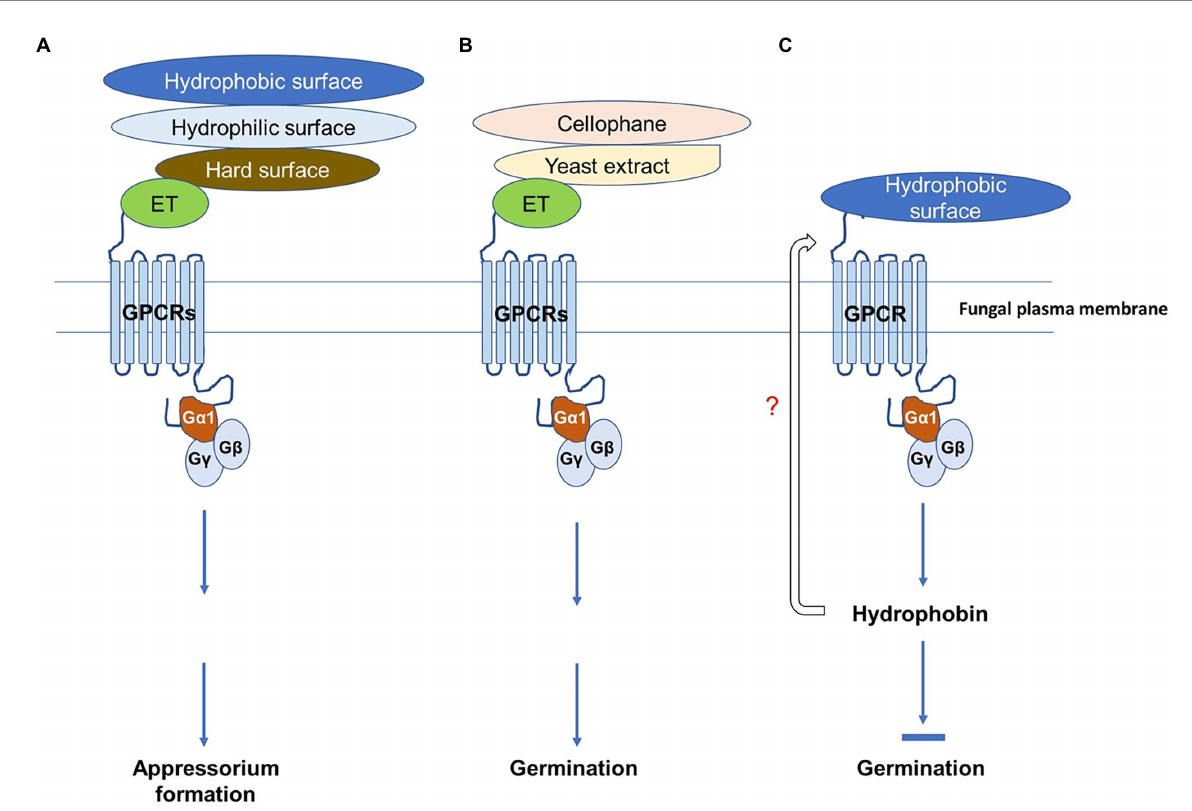
FIGURE 9 Schematic diagram of spore germination and appressorium formation regulated by different surface cues mediated by CaG α 1 (G α 1) signaling in Colletotrichum asianum TYC-2. (A) Surface cue sensing of C. asianum to hydrophobic, hydrophilic and hard surface and the fruit-ripening hormone ethylene for appressorium formation is mediated via the G-protein coupled receptor (GPCR)-CaG α 1 signaling. (B) Chemical sensing of C. asianum to cellophane, yeast extract and ethylene for spore germination is mediated via the GPCR-CaG α 1 signaling. (C) Hydrophobin is probably involved in the negative regulation of GPCR-CaG α 1 signaling on spore germination of C. asianum on hydrophobic surface. In this diagram, different stimuli might bind to different GPCRs, but all signaling pathways shown in this figure are mediated by CaG α 1 for spore germination and appressorium